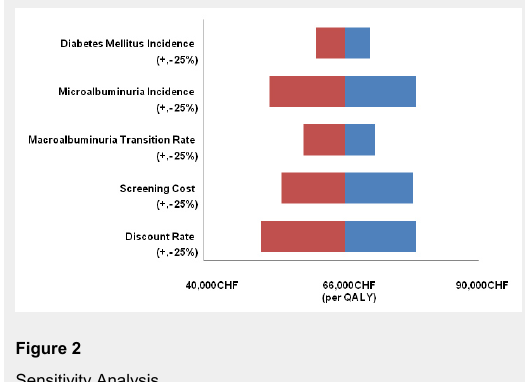
Sensitivity Analysis. One-way sensitivity analysis, which shows the impact of a change in key parameters of plus or minus 25%, depicted by red and blue bars, on the cost-effectiveness ratio of annual screening versus no screening of the full population, starting at age of 50